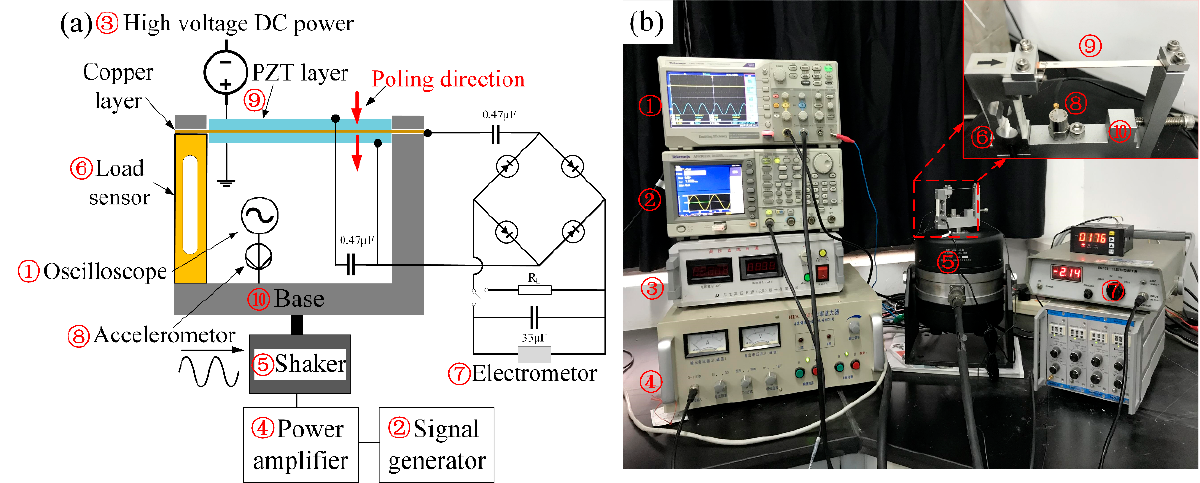
Figure 2. ( a ) Illustration of the measurement setup; ( b ) Photograph of the experimental setup. A brass layer is sandwiched and glued with two PZT-5A piezoelectric layers